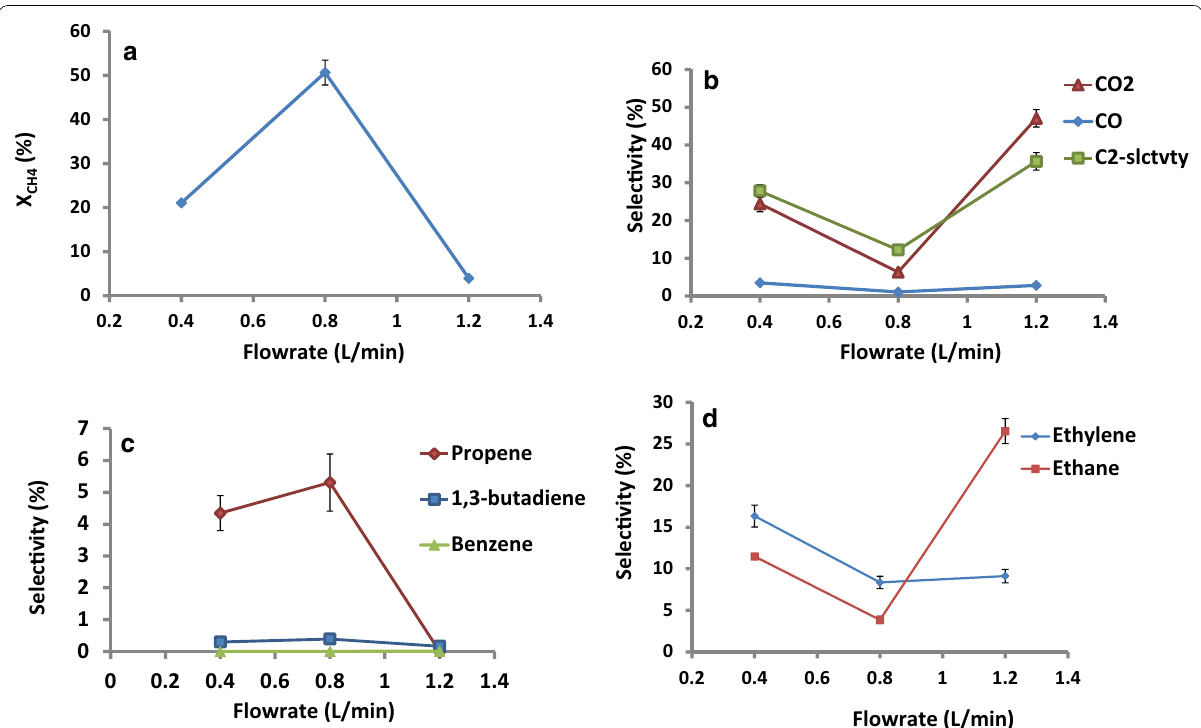
Fig. 5 Effect of flowrate on ( a ) conversion of methane, ( b ) selectivity for C 2 hydrocarbons and carbon oxides, ( c ) selectivity of C 3 –C 6 hydrocarbons, ( d ) selectivity of C 2 hydrocarbons under the experimental conditions: 10 g of 2% Fe-loaded eggshell catalyst. 650 ºC, CH 4 :O 2